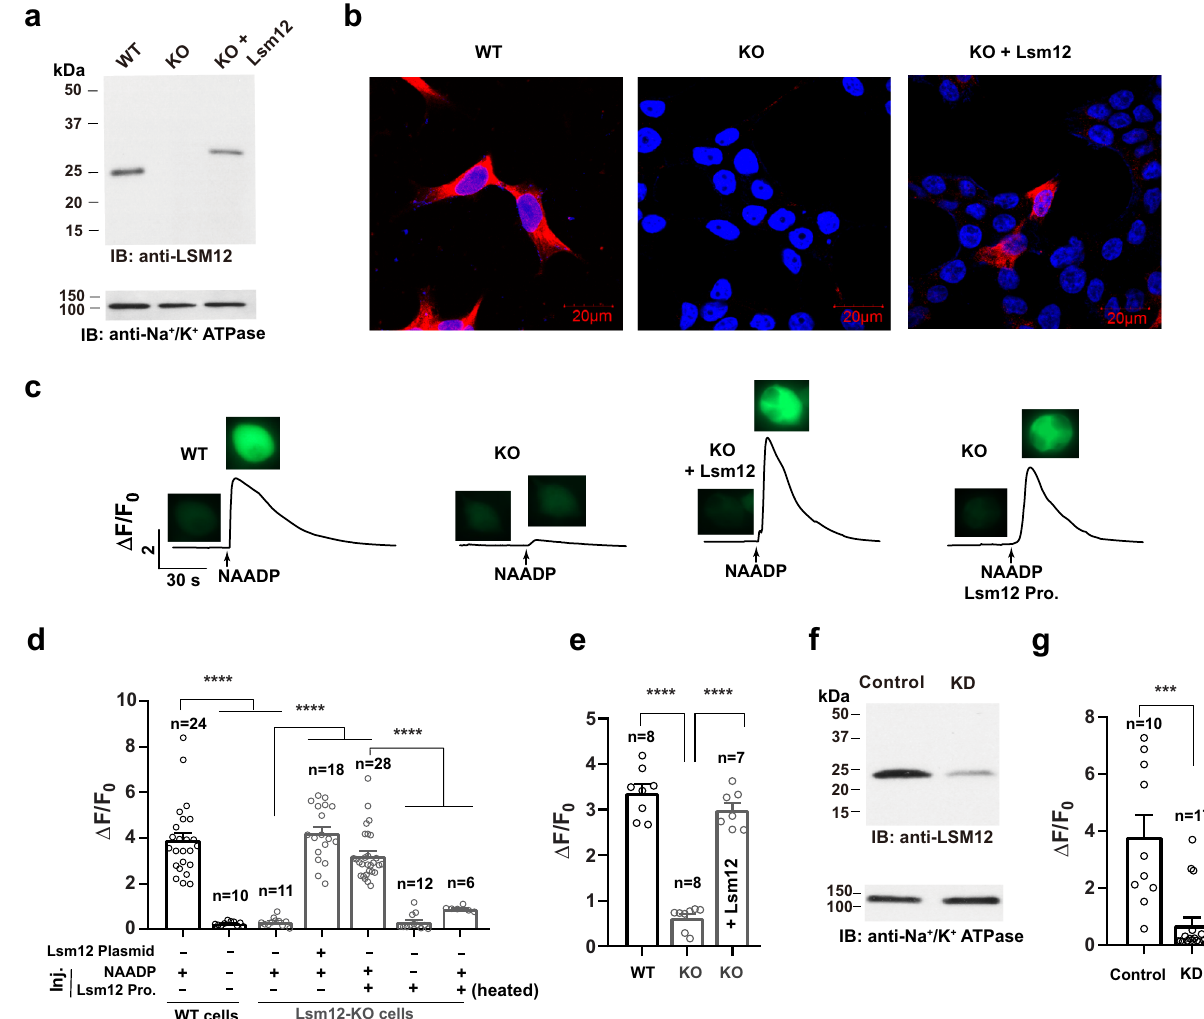
Fig. 2 Lsm12 is essential for NAADP-evoked Ca 2 + release. a , b Immunoblot ( a ) and immuno fl uorescence ( b ) assays show the loss of Lsm12 expression in the Lsm12-KO cell line. Lsm12 and cell nuclei are shown in red and blue, respectively. c Time course and cell images of NAADP-induced change in fl uorescence of Ca 2 + indicator in TPC2-expressing HEK293 WT and Lsm12-KO cells with/without exogenous Lsm12 expression or protein injection. Cell images were taken before NAADP injection and at the peak of Ca 2 + increase after injection. d Averaged NAADP-induced changes in Ca 2 + indicator fl uorescence in TPC2-expressing HEK293 WT and Lsm12-KO cells. Exogenous Lsm12 was introduced to cells by either plasmid transfection or protein injection (labeled at the bottom). e Averaged NAADP-induced changes in Ca 2 + indicator fl uorescence in TPC1-expressing HEK293 WT and Lsm12-KO cells. Exogenous Lsm12 was introduced to cells by plasmid transfection (labeled in the column). f Immunoblot of Lsm12 in cell lysates of SK-BR-3 control and Lsm12-KD cells. g Averaged NAADP-induced changes in Ca 2 + indicator fl uorescence in TPC2-expressing SK-BR-3 control and Lsm12-KD cells. Data were presented as mean value ± SEM. Unpaired Student ’ s t -test (two-tailed) was used to calculate p values. *** and **** are for p values ≤ 0.001 and 0.0001, respectively. IB immunoblot, KO knockout, Pro. protein, Inj. injection, KD